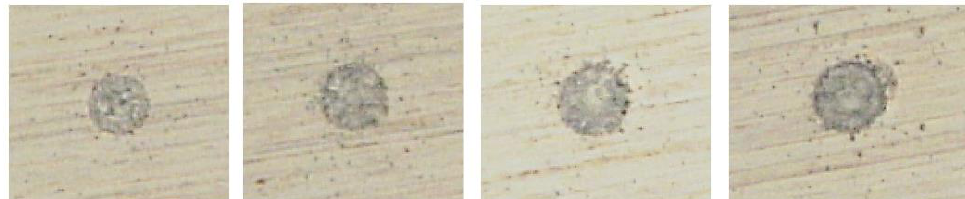
Figure 10. Optical microscopy image of typical static pulse ablations with power variation from 30%, 40%, 50%, and 60% of laser source power.